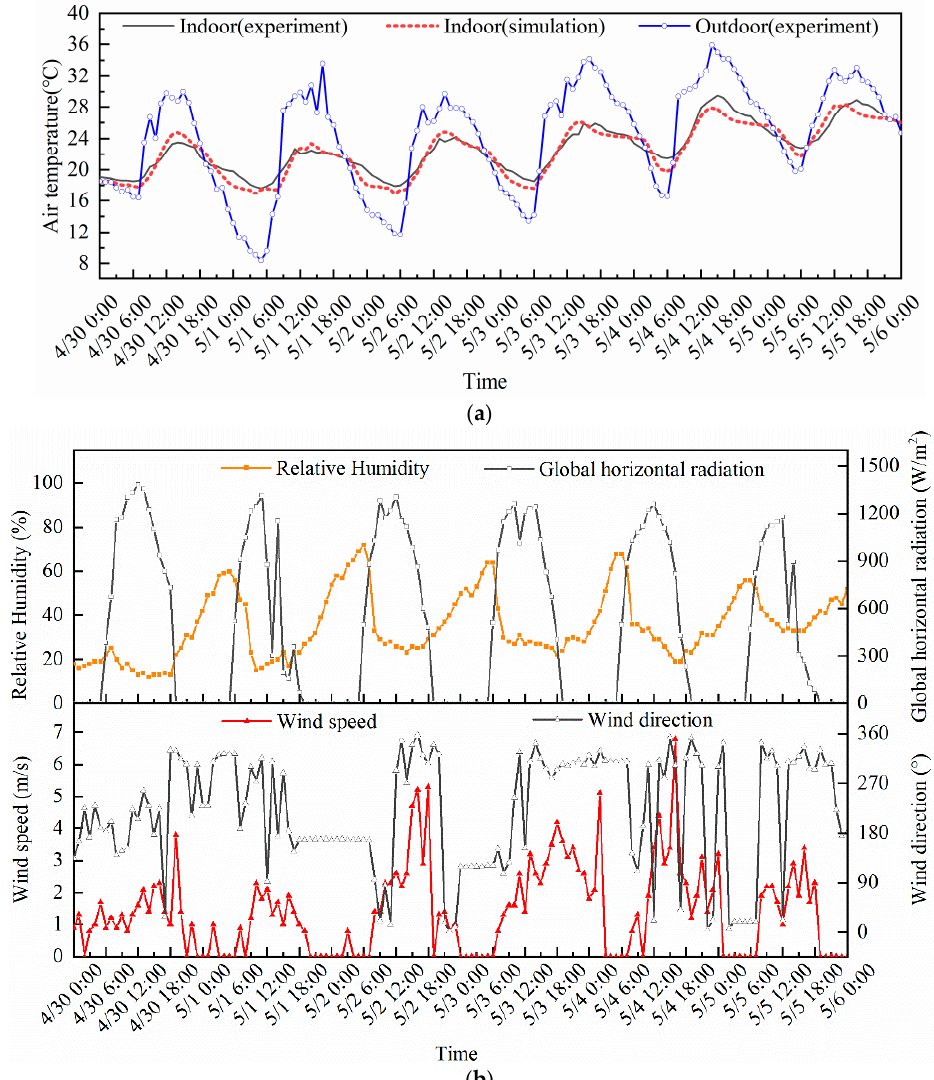
Figure 9. ( a ) Indoor air temperature profile compared between simulation and experimental results and the associated ( b ) outdoor weather data during a week in April and May 2022.